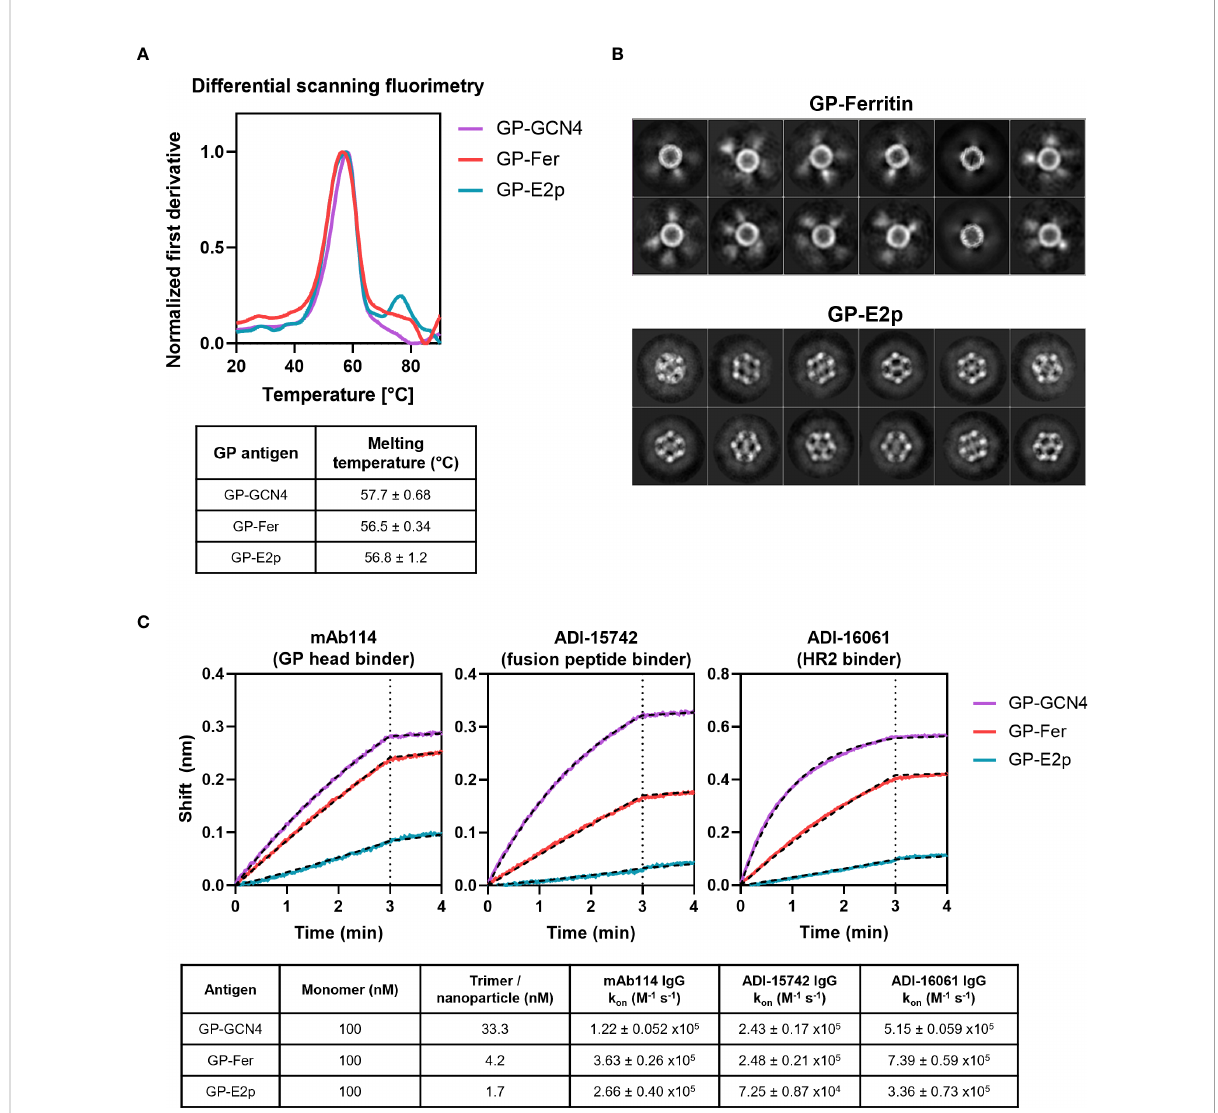
FIGURE 2 Stability and antigenicity of GP D mucin are not perturbed when displayed on protein nanoparticles. (A) Stability of GP-GCN4, GP-Fer, and GP- E2p were assessed using differential scanning fl uorimetry using a melting gradient from 20°C to 90°C at a rate of 1°C per minute. Melting temperatures were obtained from the Prometheus software using the fi t of the fi rst derivative of the 350/330 nm fl uorescence ratio as a function of temperature. (B) 2D class averages from cryo-EM analysis of GP-Fer and GP-E2p. (C) Binding of mAbs to GP-GCN4, GP-Fer, and GP-E2p was assessed using puri fi ed mAbs immobilized on anti-human Fc biosensor tips. mAbs were dipped into antigen (100 nM, subunit concentration) and association was monitored for 3 min. Binding experiments were performed in experimental duplicate and k on values were calculated by fi tting curves with an association/dissociation kinetic equation in GraphPad Prism. Binding curves from one representative replicate are shown with curve fi ts plotted as hashed black lines. Average k on values for each binding reaction with standard deviation are shown in